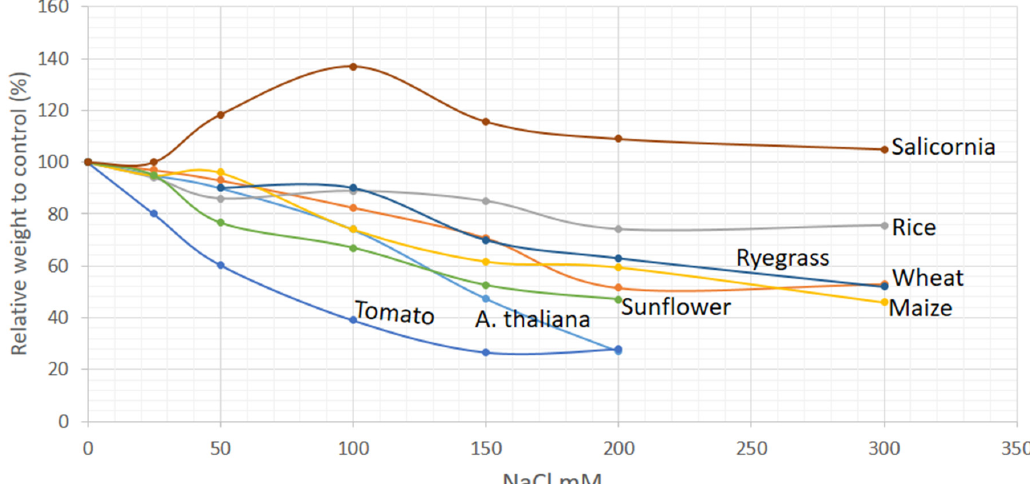
Figure 1. Effect of salinity level on relative biomass changes in crop plants. The relative dry weight compared to control was used as a growth parameter. The irrigation of soil by saline water (NaCl) from 0–300 mM was used salt application. Sources of the data were: A. thaliana : [25,32,41,42], wheat: ( Triticum aestivum ) [30,36,43,44], rice ( Oryza sativa ): [31,33], maize ( Zea